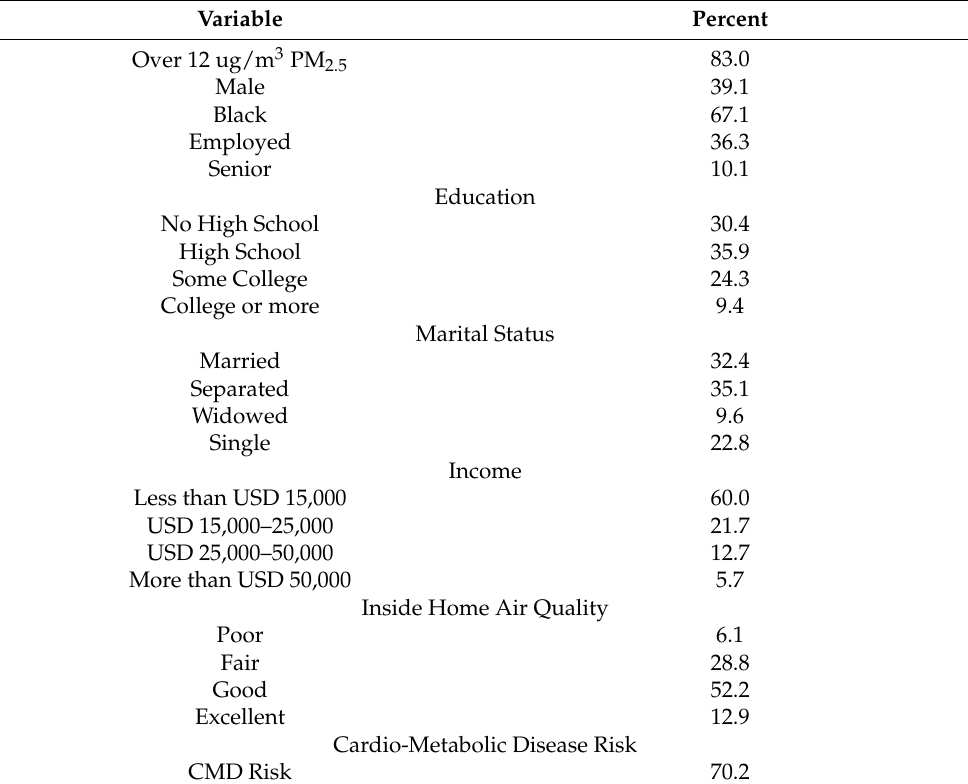
Table 1. Southern Community Cohort Study Participant Characteristics Enrolled from Community Health Clinics in 12 Southern States (2002–2009) ( n = 4460).